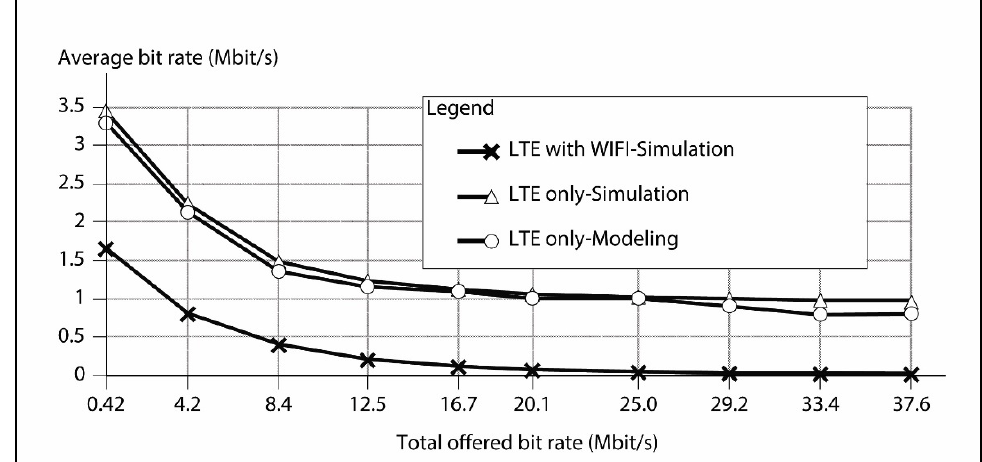
Figure 10. Average bit-rate comparison.